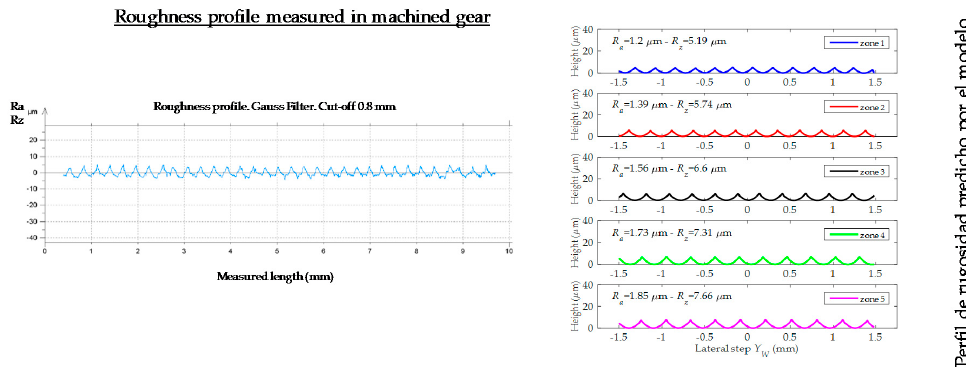
Figure 14. Roughness comparison of predictive model vs. measured roughness.